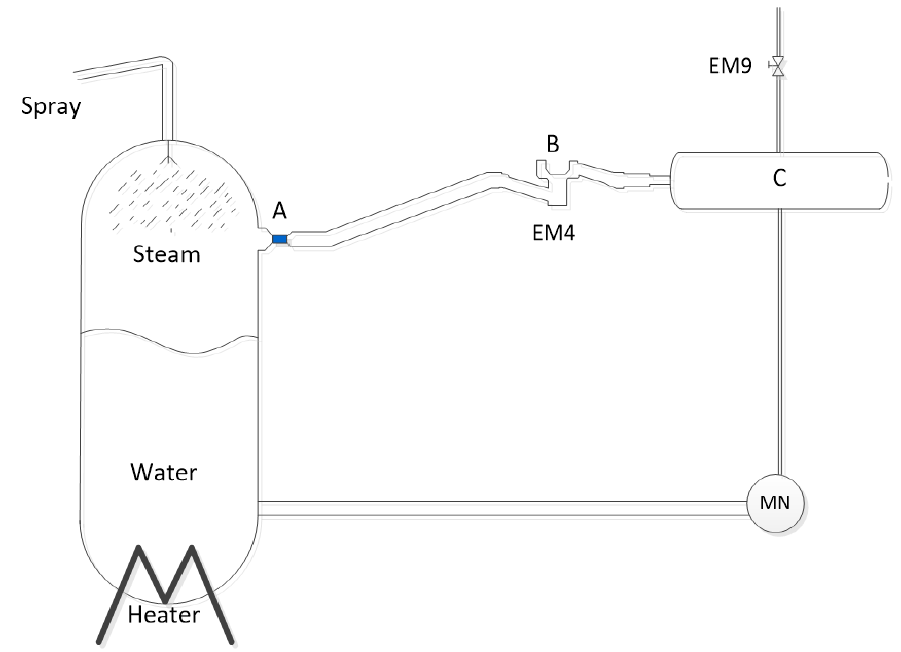
Figure 1. Pressurizer liquid level measurement system.